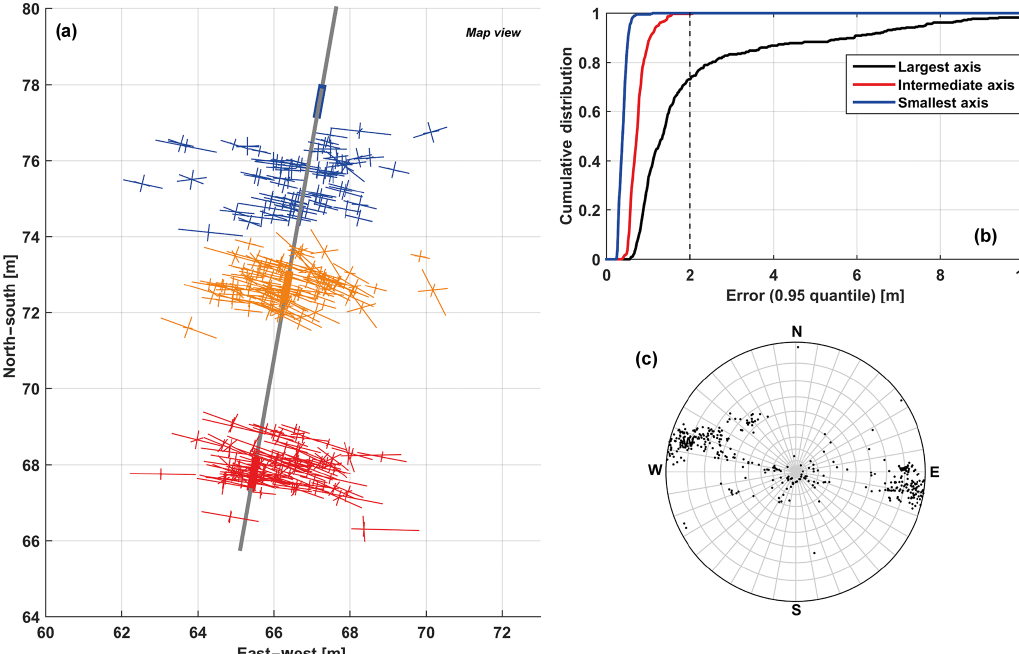
Figure 6. Error estimates for event locations: (a) error ellipsoids shown in map view, (b) cumulative distribution of the errors along the three principal axes of the error ellipsoids and (c) stereographic projection (lower hemisphere) of the largest error direction. The errors are generally largest in the E–W direction.